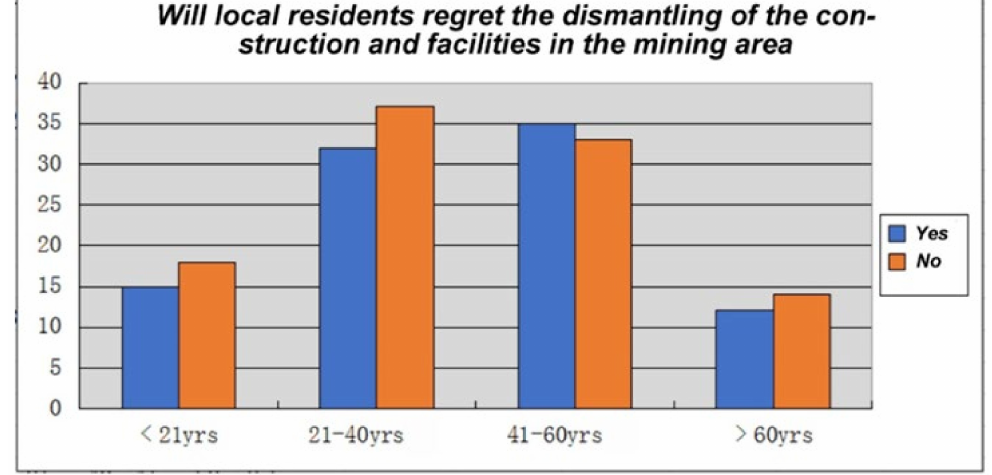
Figure 11. Whether residents would regret if the buildings and equipment of mining be